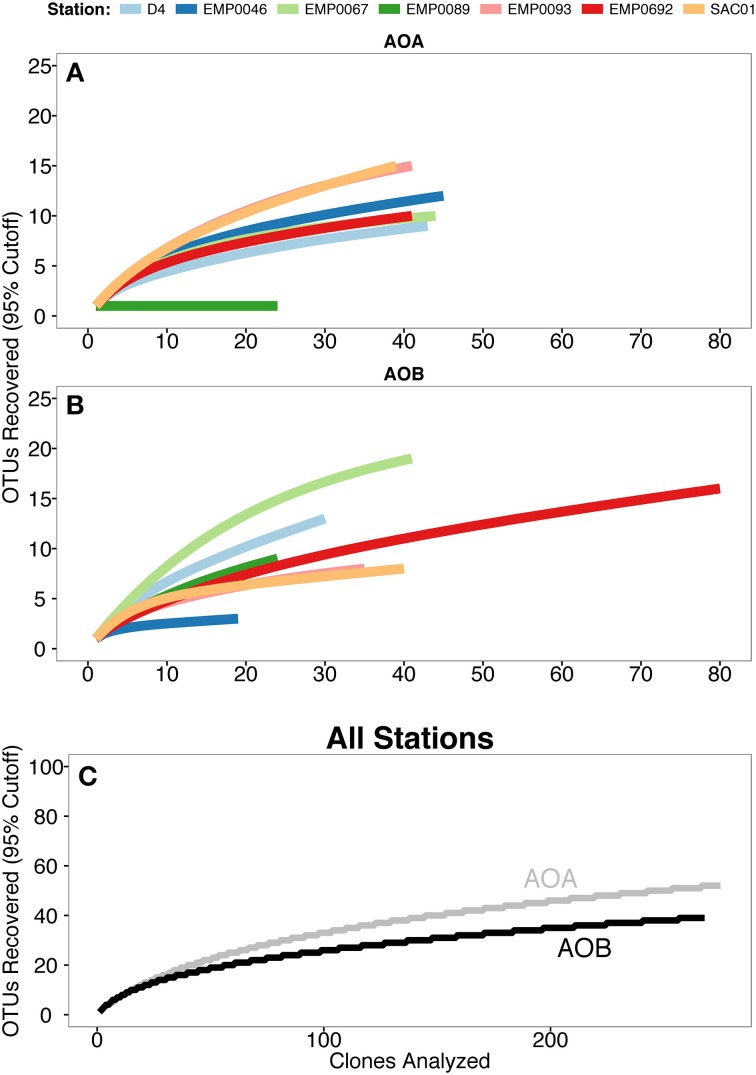
Rarefaction curves of amoA OTU (≥95% similarity) data. (A) AOA and (B) AOB, with color denoting sampling site. (C) Combined OTU data from all stations, with AOA amoA data in gray and AOB amoA in black.